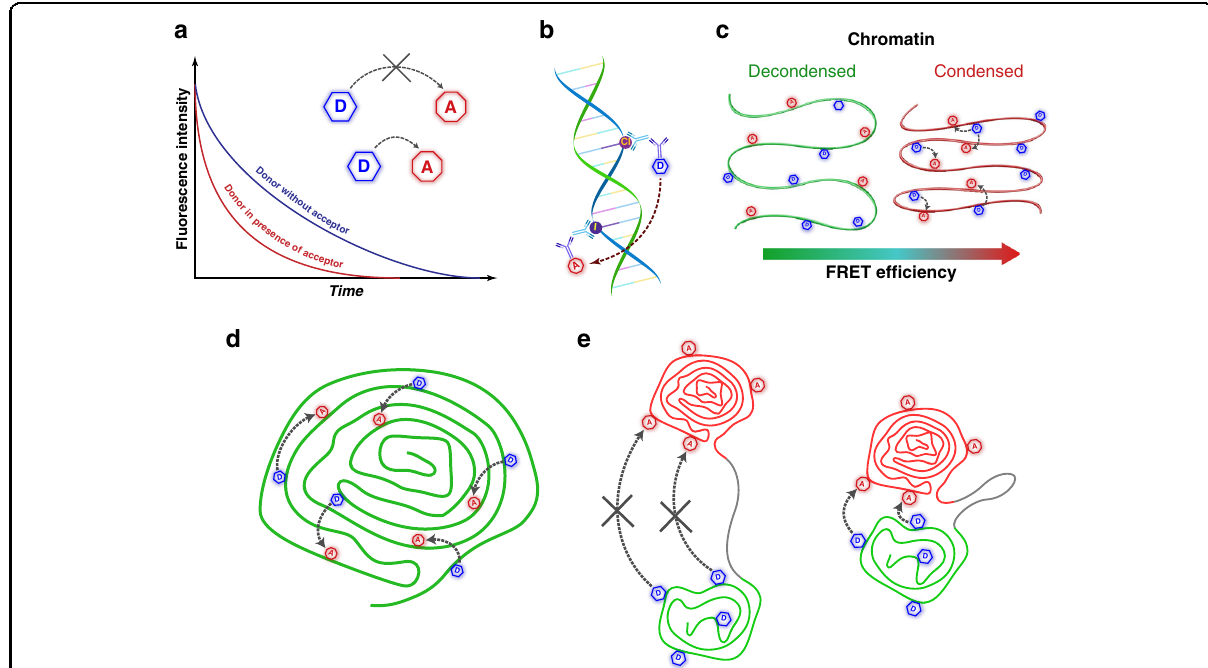
Fig. 3 Schematic illustration of the FLIM-FRET assay to study genomic DNA compaction. a Basic FLIM-FRET mechanism. b Direct labeling of the genomic DNA by incorporation of fl uorophore-tethered nucleotides. c Relation between chromatin condensation levels and FRET ef fi ciency. Scheme of simultaneous ( d ) and sequential labeling of the chromatin domains ( e ) during the S-phase of the cell